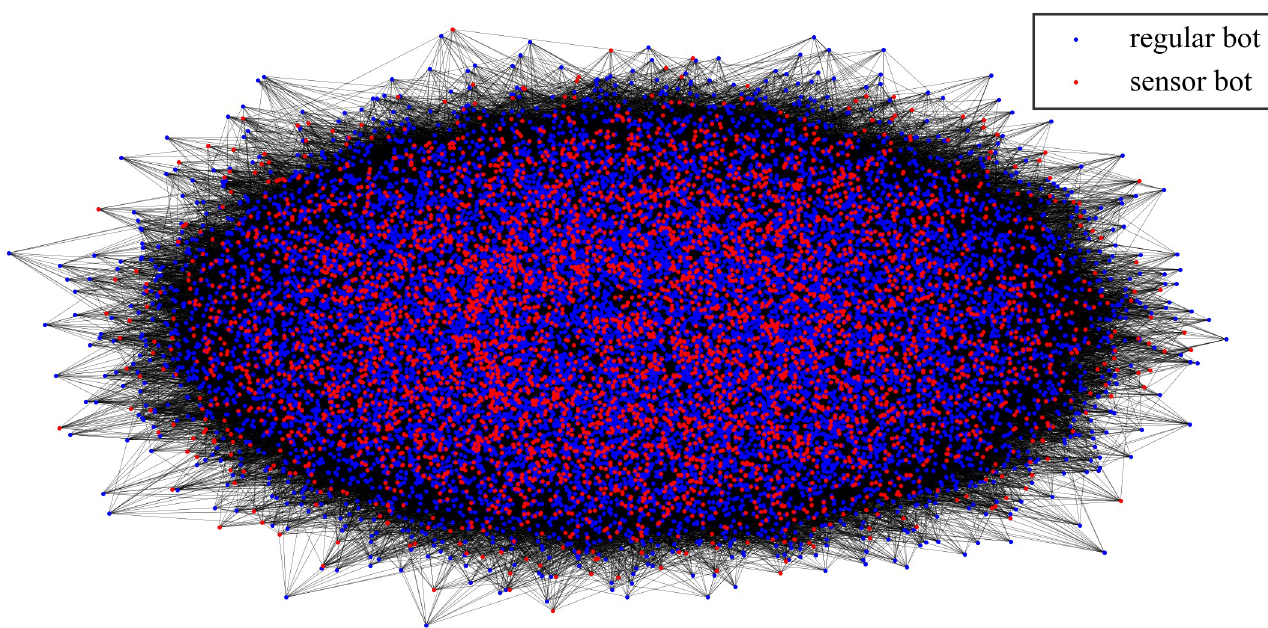
Fig 6. A network overview of the simulated botnet.